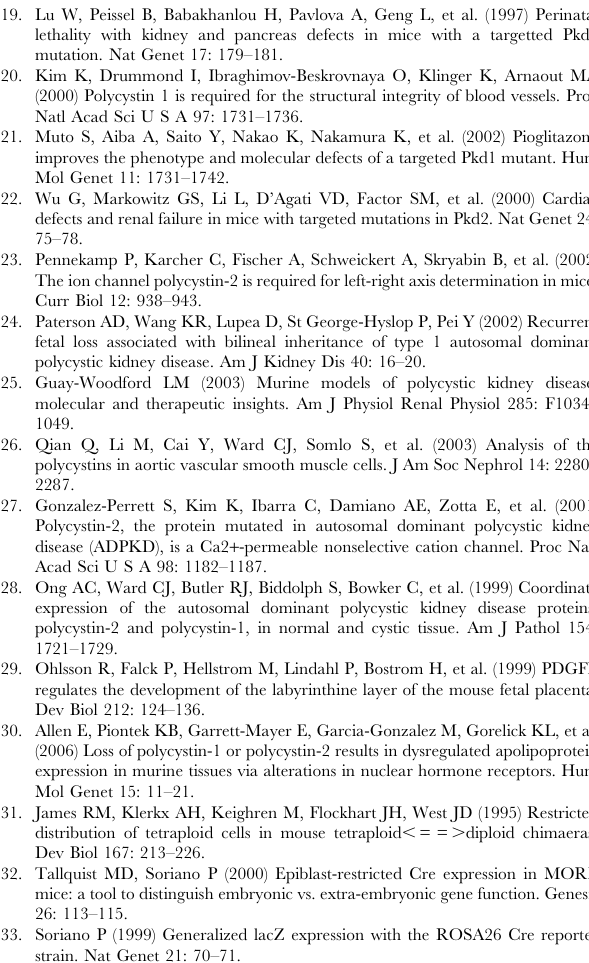
Table S2 Genotypes resulting from mating of Pkd2 allele